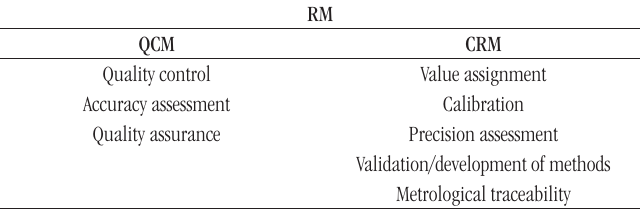
taBLE 1 − Use associated with RMs RM QCM CRM Quality control Value assignment Accuracy assessment Calibration Quality assurance Precision assessment Validation/development of methods Metrological